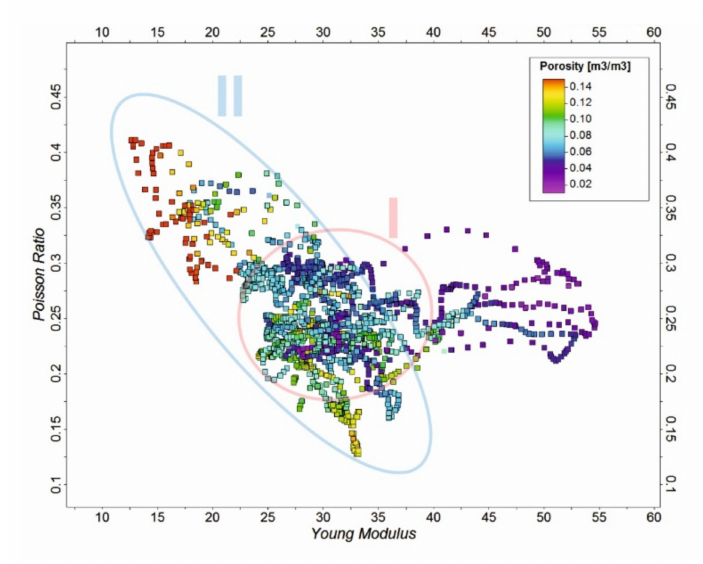
Figure 9. Young’s modulus vs. Poisson’s ratio as a function of porosity within Source I (red circle) and Source II (blue circle).